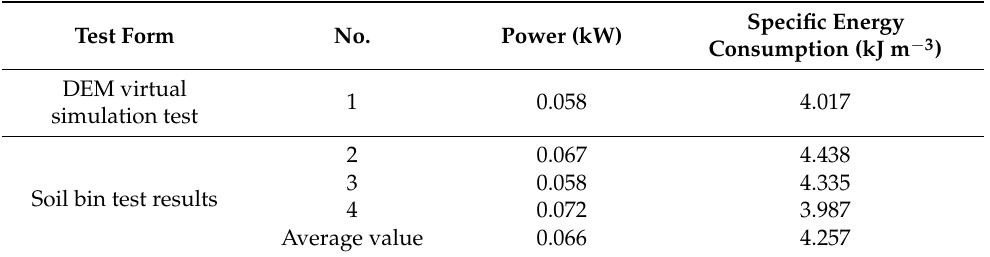
Table 3. Comparison of DEM virtual simulation test results with indoor soil bin test